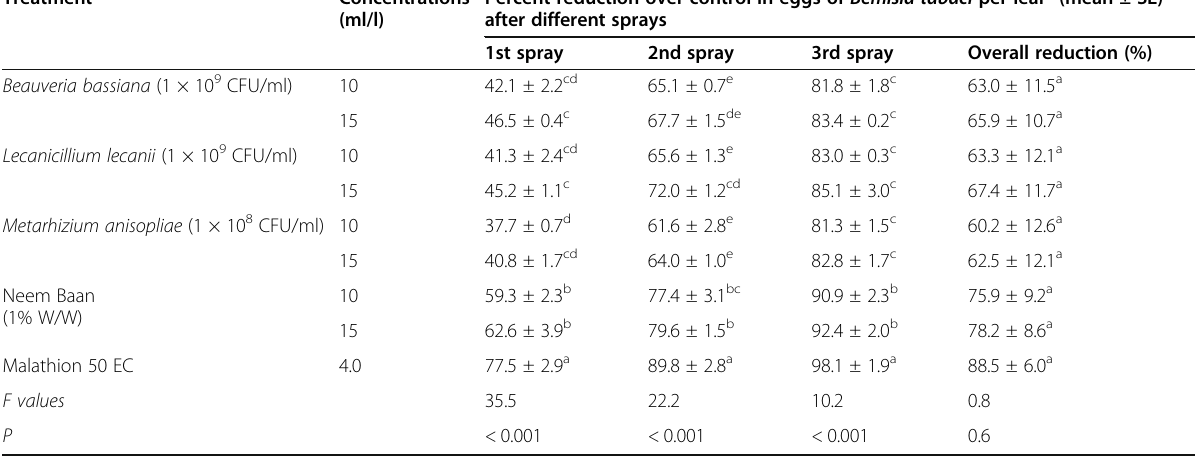
Table 3 Efficacy of different biopesticides against eggs of Bemisia tabaci on cucumber under net house conditions during autumn cropping season (2018)